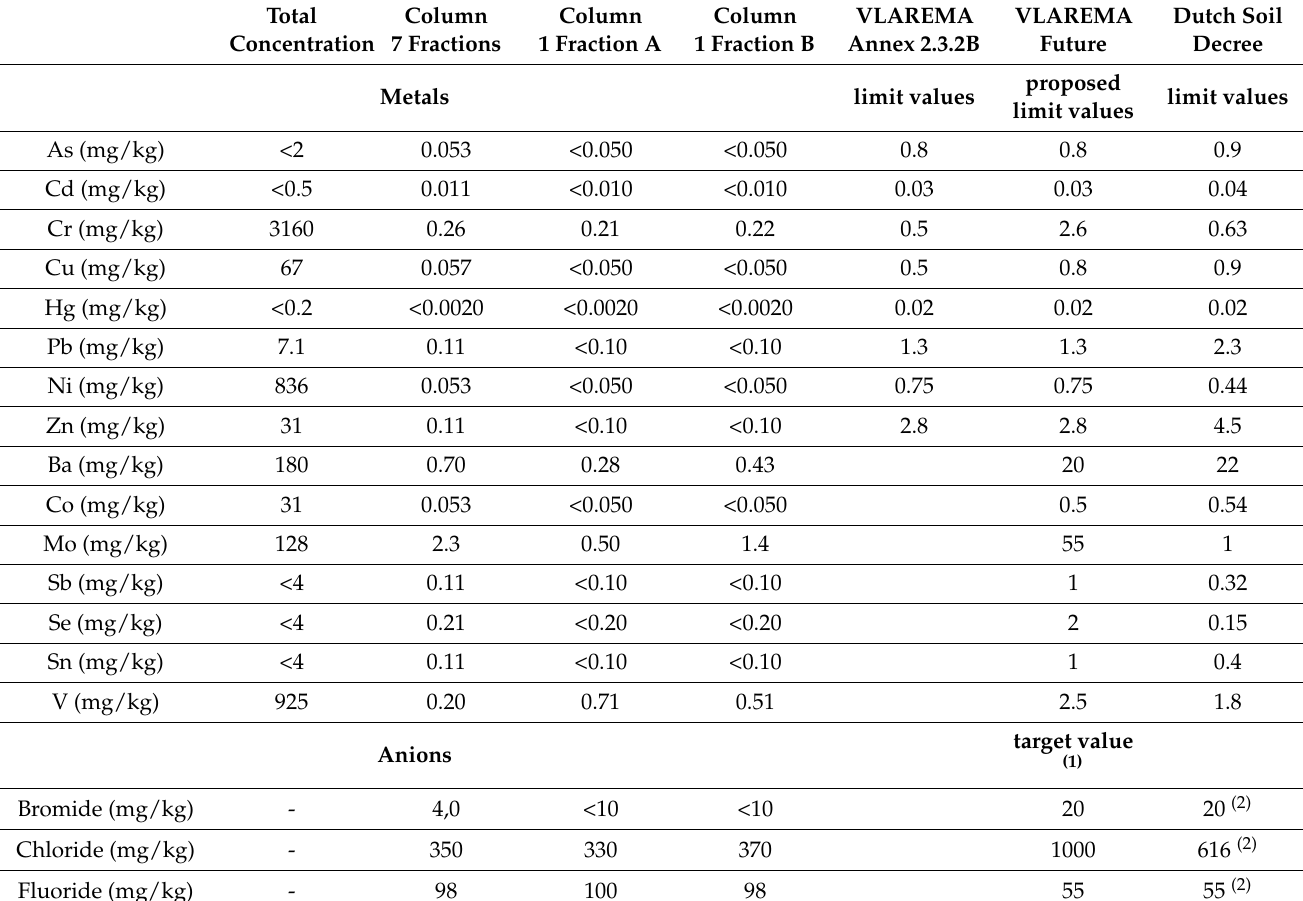
Table 3. Total element content and leaching concentrations (mg/kg dry matter) as determined by upstream column percolation testing.